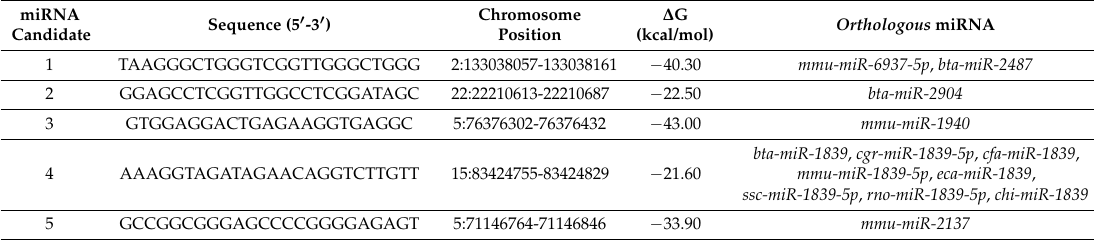
Table 2. Summary of putative novel miRNAs detected by small RNA sequencing. miRNA